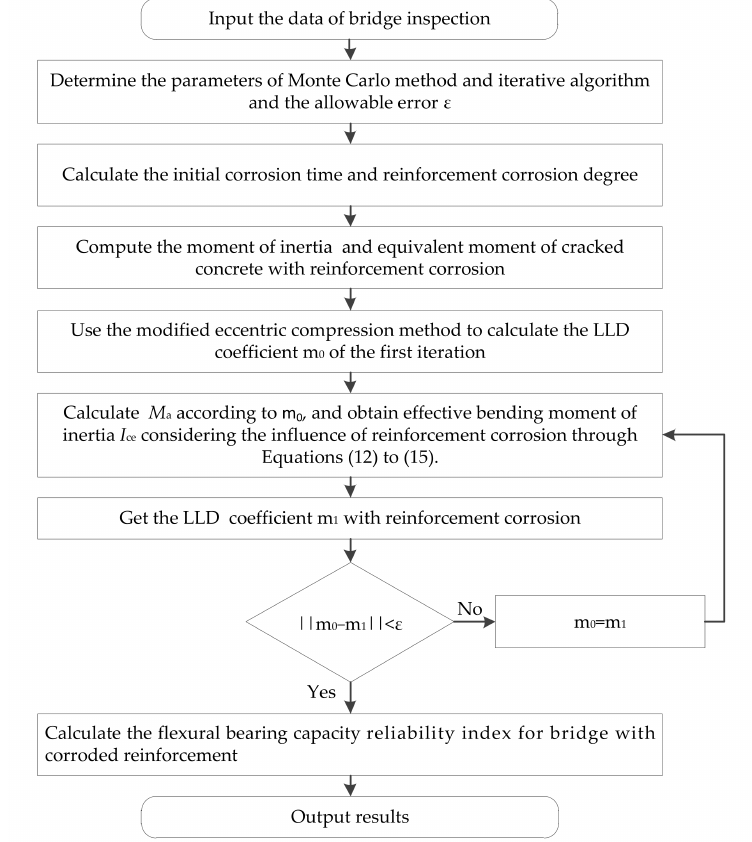
Figure 2. Flow chart of reliability